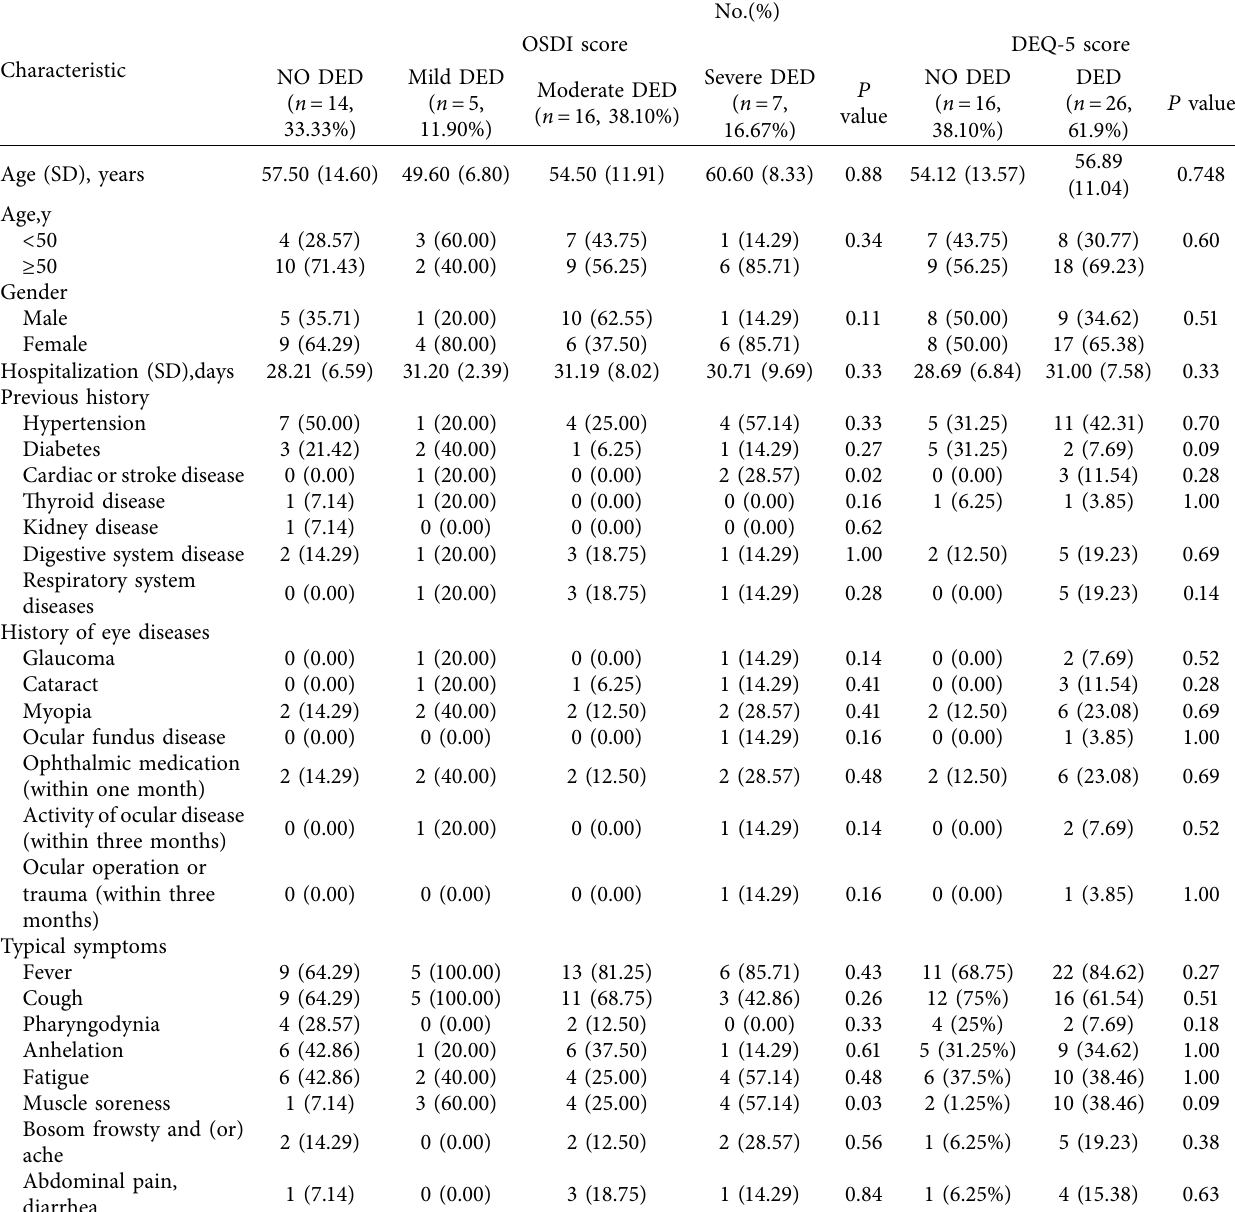
Table 3: The clinical characteristics of COVID-19 patients with subtype DED symptoms score